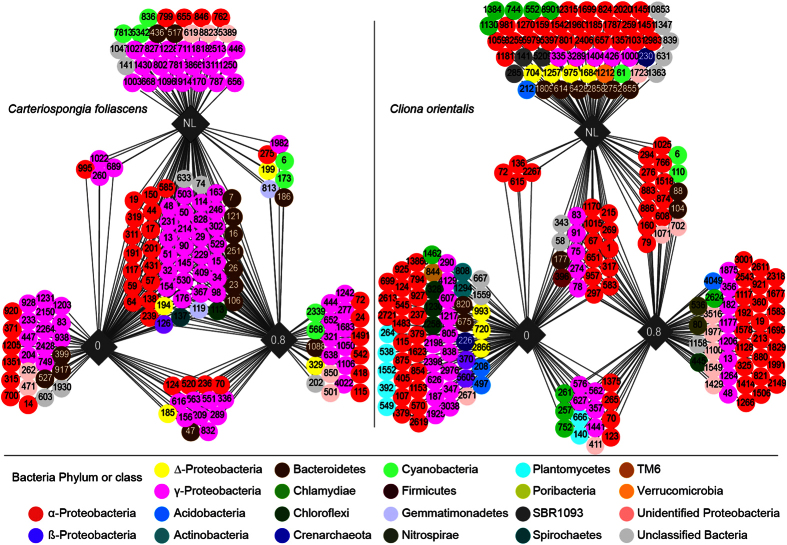
Cytoscape networks of C. foliascens and C. orientalis microbiome.Networks of the microbiome community on 3 light treatments (0, 0.8 and natural light (3.2−6.5 mol photons m−2 d−1)) for the phototrophic species C. foliascens and C. orientalis. Circles correspond to different OTUs (with OTU numbers) and colours relate to their Phylum or Class level in the case of Proteobacteria. Only samples at the end of the 28 d experimental period were used (n = 3 per treatment).